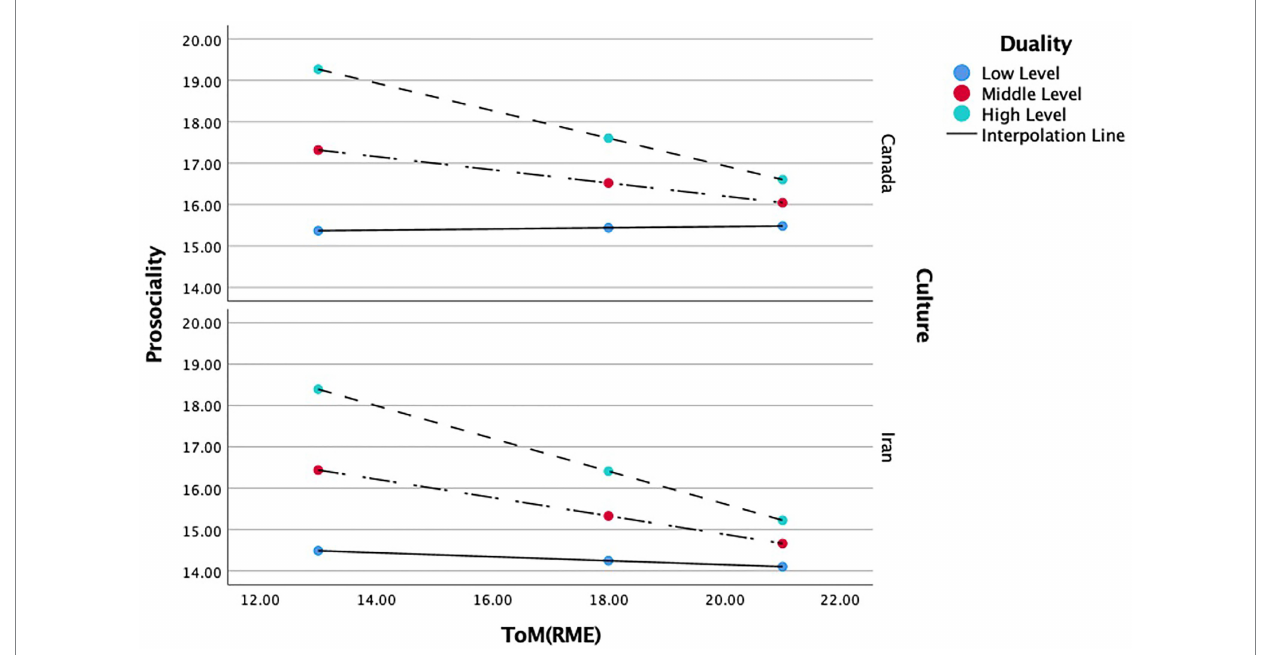
FIGURE 4 Moderating role of duality and culture in the relationship between ToM and prosociality.